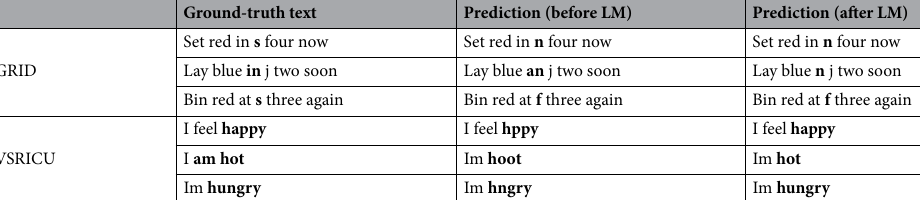
Table 3. Samples of misspelled predictions of the full pipeline. Ground-truth labels are shown in the left column, raw predictions by the STT module and the language model output are shown in the middle and right